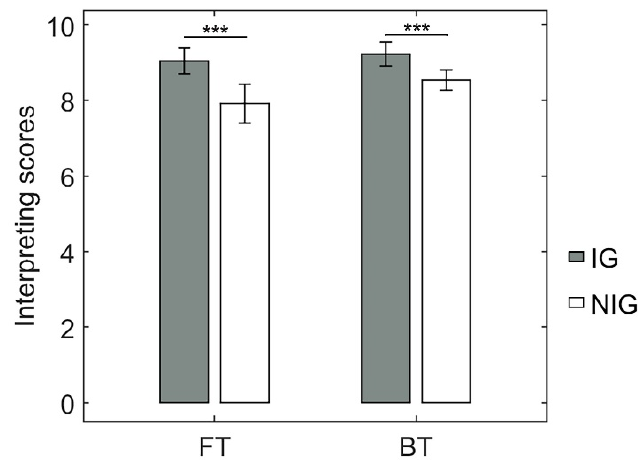
Figure 2. Behavioral performance of the translation tasks. *** p < 0.001.